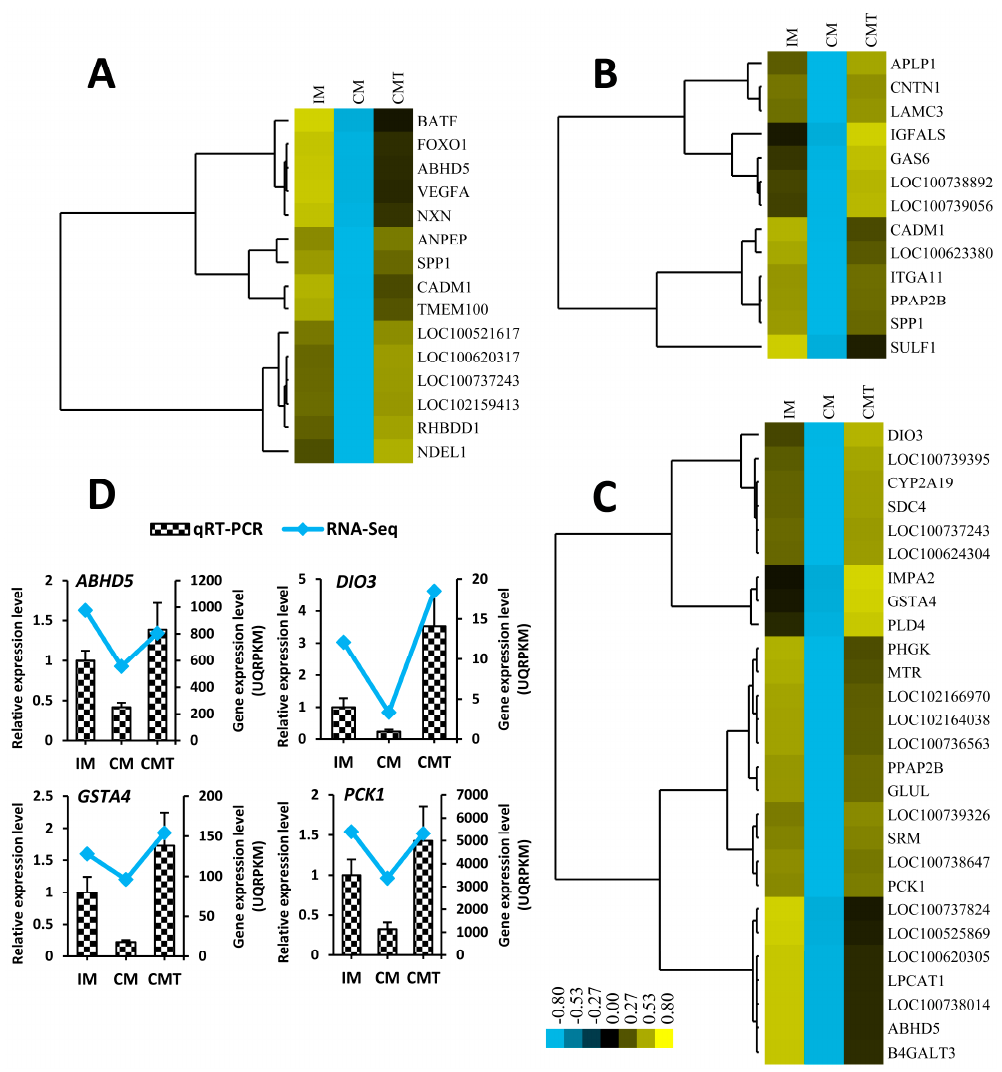
Figure 6. DEGs involved in cell differentiation, cell adhesion and small molecule metabolic process: ( A ) heat map for genes involved in cell differentiation; ( B ) heat map for genes involved in cell adhesion; ( C ) heat map for genes involved in small molecule metabolic process; and ( D ) expression levels of four genes ( ABHD5 , DIO3 , GSTA4 , and PCK1 ) detected by qRT-PCR that were in agreement with the RNA-Seq results. Data were expressed as means ± SEMs, n = 4 per group. IM: intact male pigs fed a HFC diet; CM: castrated male pigs fed a HFC diet; CMT: castrated pigs with testosterone replacement fed a HFC diet.